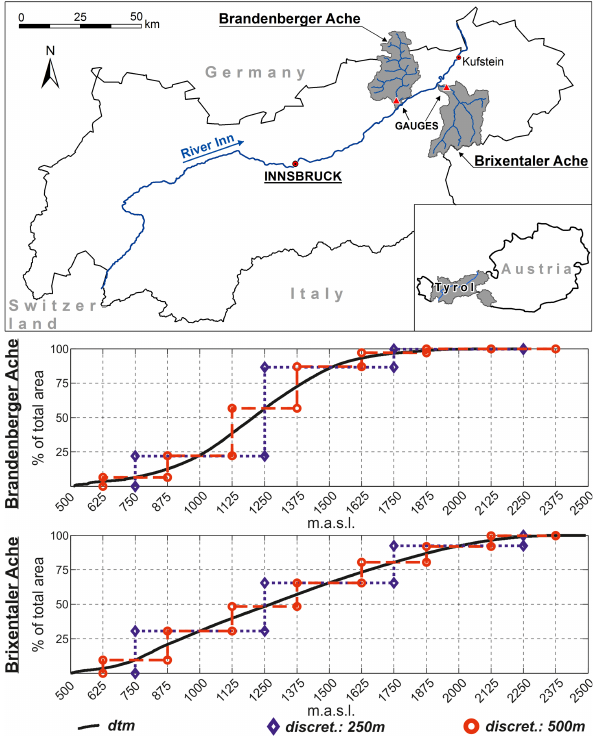
Fig. 1. Overview on the location of the modelled catchments and their hypsographic